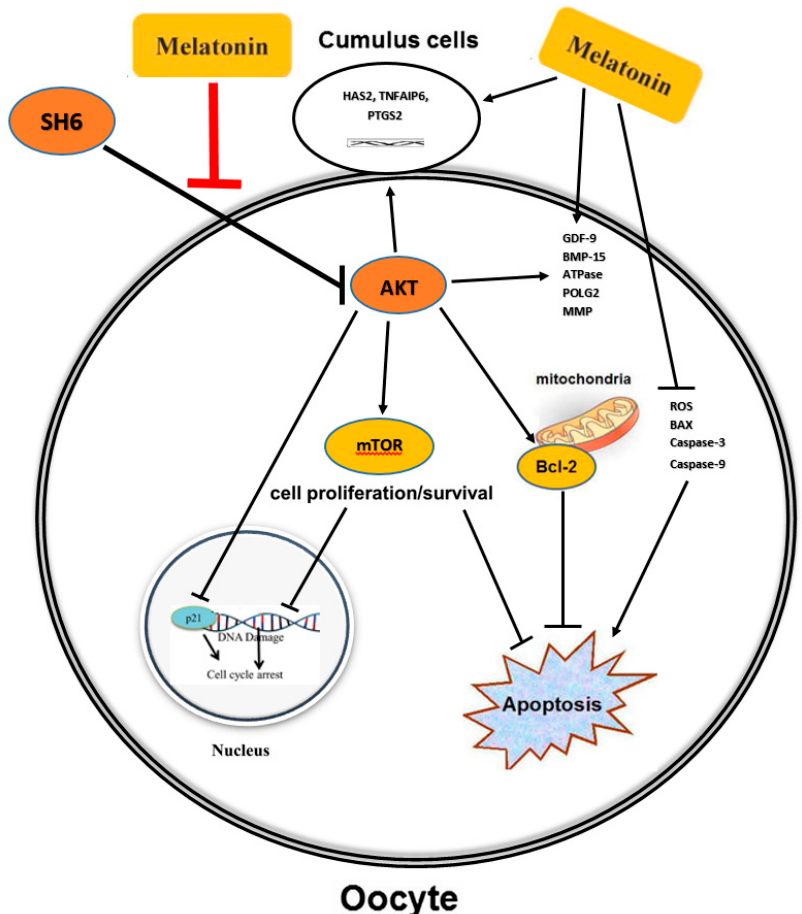
Figure 13. Proposed mechanism of action of melatonin in bovine oocyte under SH6 pressure. Melatonin protects oocyte and efficiently improves the developmental competence of embryos through different pathways. The first is based on the direct antioxidant and anti-apoptotic function of melatonin under SH6 exposure. The other is the potential interaction with the AKT activation pathway that positively increases the maturation rate of oocytes and subsequent developmental processes.